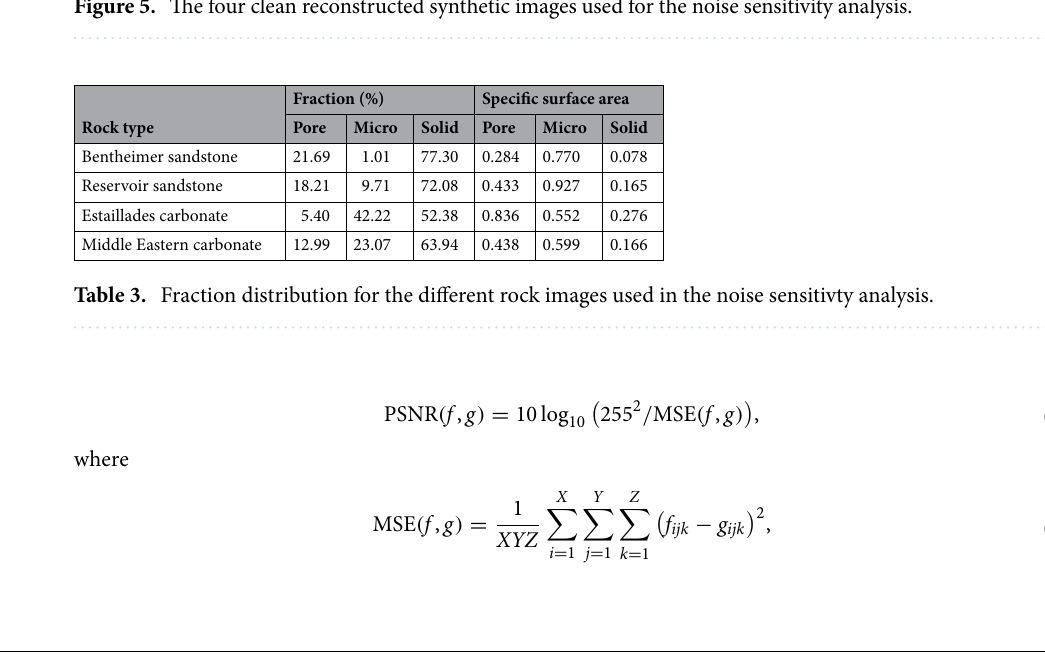
Figure 5. The four clean reconstructed synthetic images used for the noise sensitivity analysis.